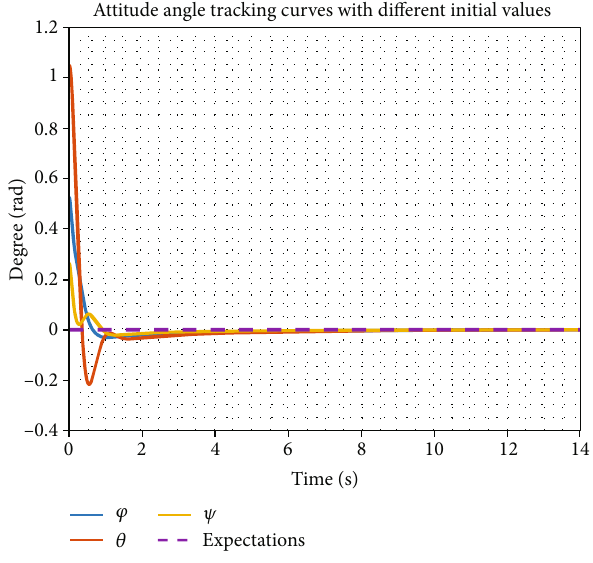
Figure 14: Attitude angle